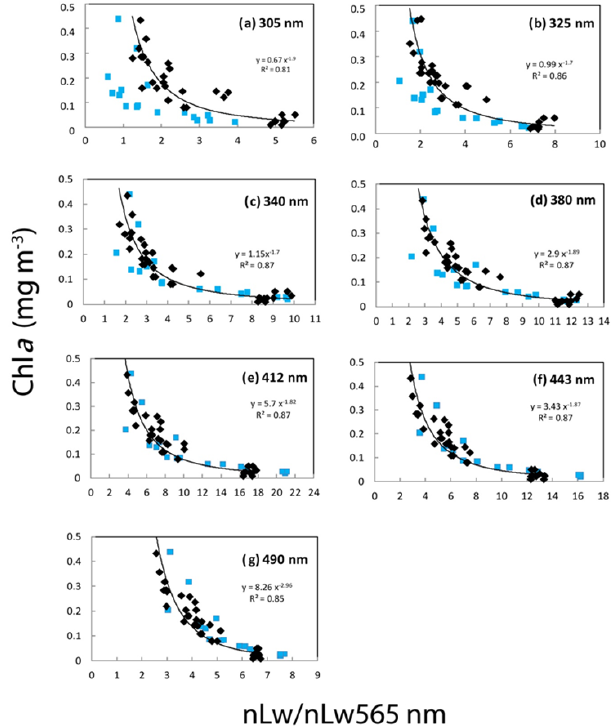
Figure 11. Correlations between the Chl a (fluorimetry) and the ratio of nL w (λ)/ nL w (565nm) at different UV and visible wave- lengths. Equations and determination coefficient ( r 2 ) of the power law are indicated for each wavelength: (a) 305, (b) 325, (c) 340, (d) 380, (e) 412, (f) 443 and (g) 490nm. All stations of the OUT- PACE (in black) and BIOSOPE (in blue) transect are